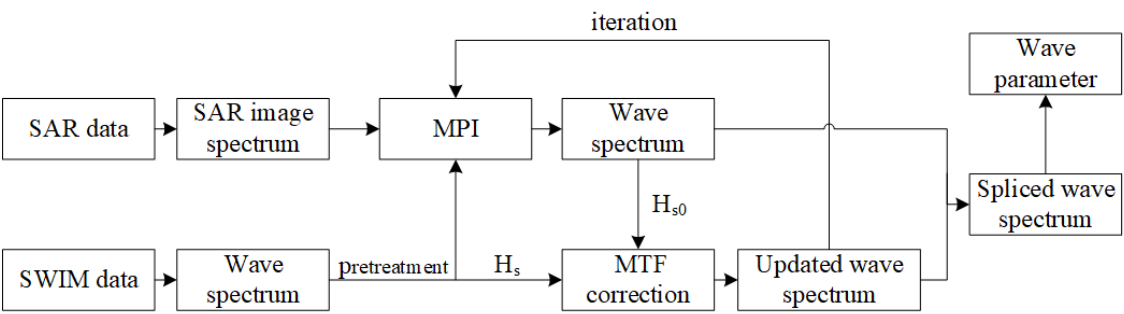
Figure 2. Flowchart of wave joint inversion method for SAR and wave spectrometer.